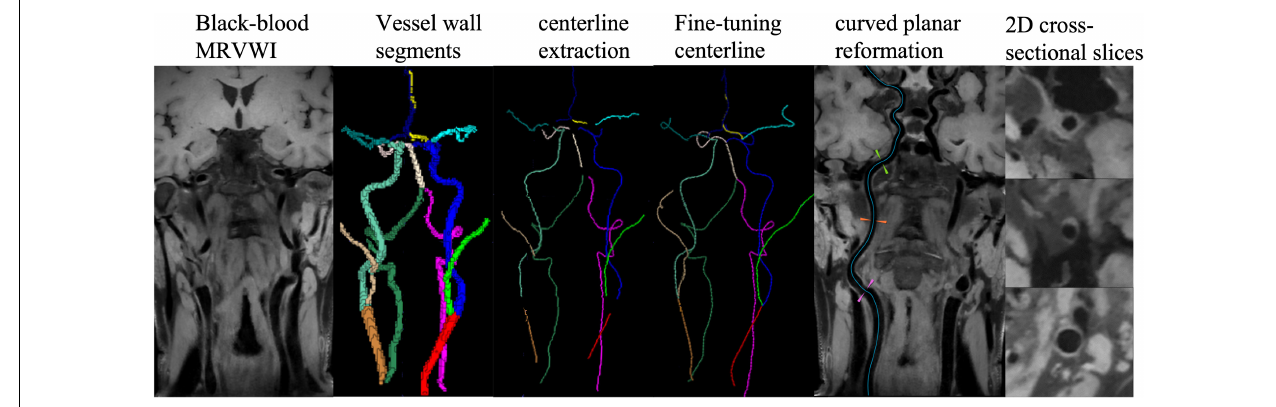
FIGURE 1 | The workflow for proposed centerline extraction of intracranial and carotid artery.